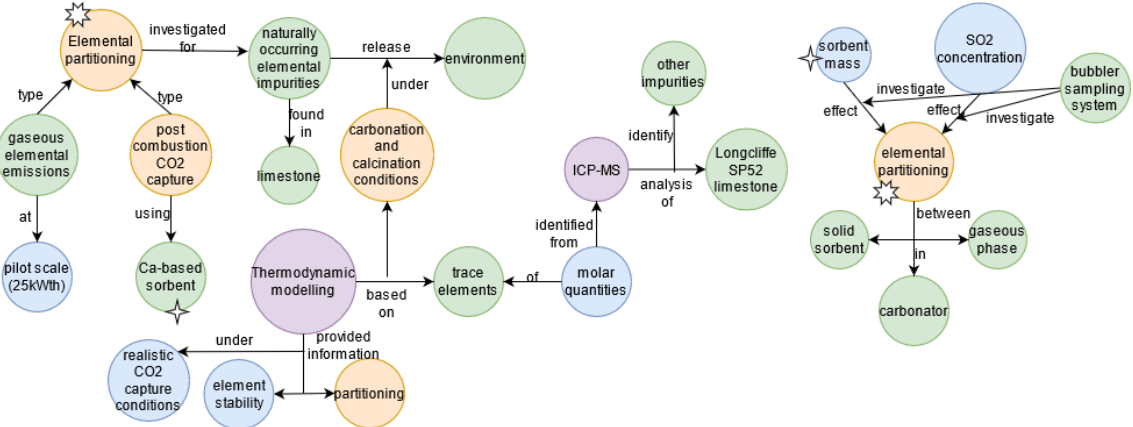
Figure A6. Structured KG representation of a Chemistry domain publication Abstract [70] as process, method, material, and data typed entities.